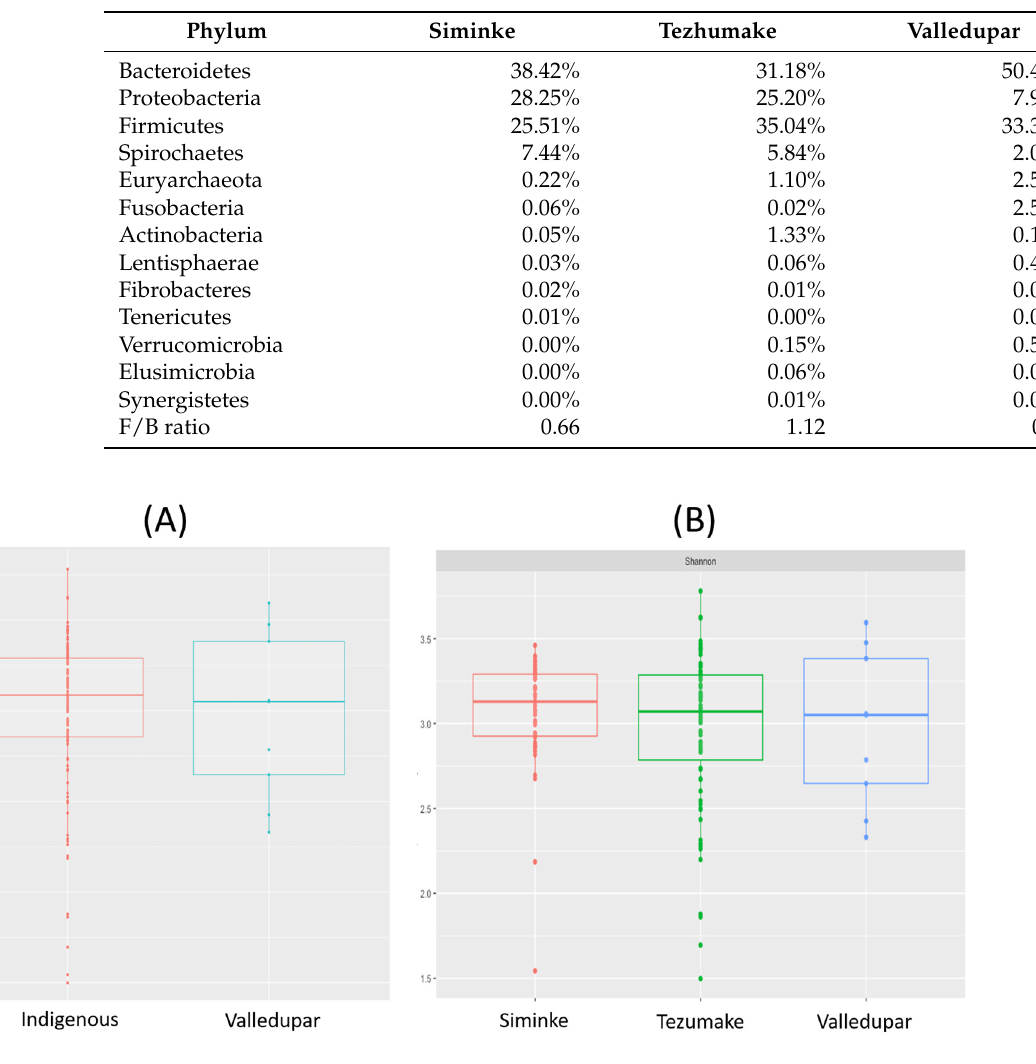
Figure A1. Shannon alpha diversities. A: Indigenous vs. Valledupar; B: All populations.